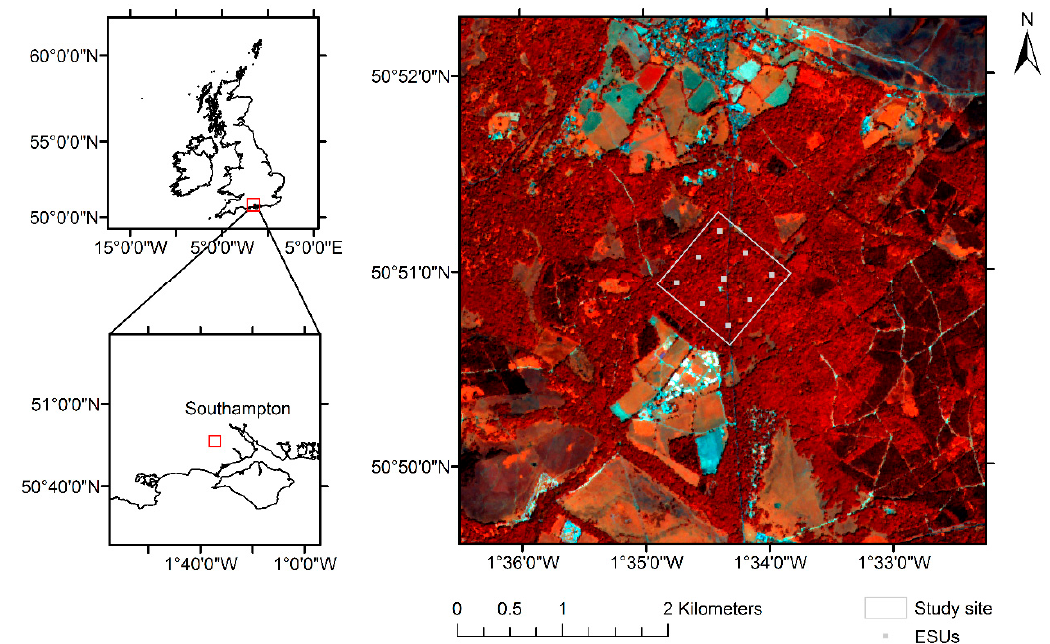
Figure 1. Location of the study site within the United Kingdom. The background image is an MSI false colour composite acquired on 19 July 2016. Table 1. Statistics of key stand attributes after Cantarello and Newton [43] and Mountford et al. [44]. Stand Attribute